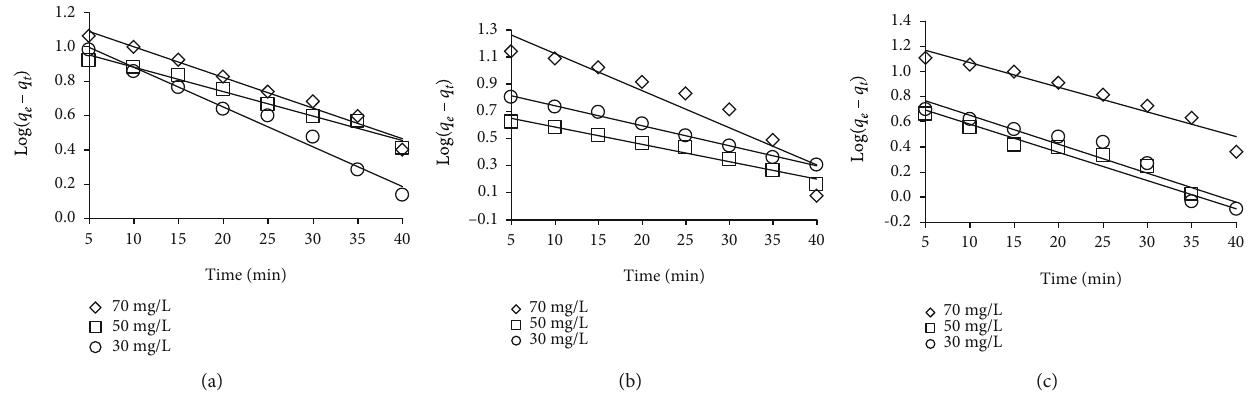
Figure 14: Lagergren fi rst-order plot for adsorption of (a) Pb (II), (b) Cr (III), and (c) Cd (II) on amidoxime chelating resin for di ff erent initial feed concentrations at pH5 and temperature at 25 °